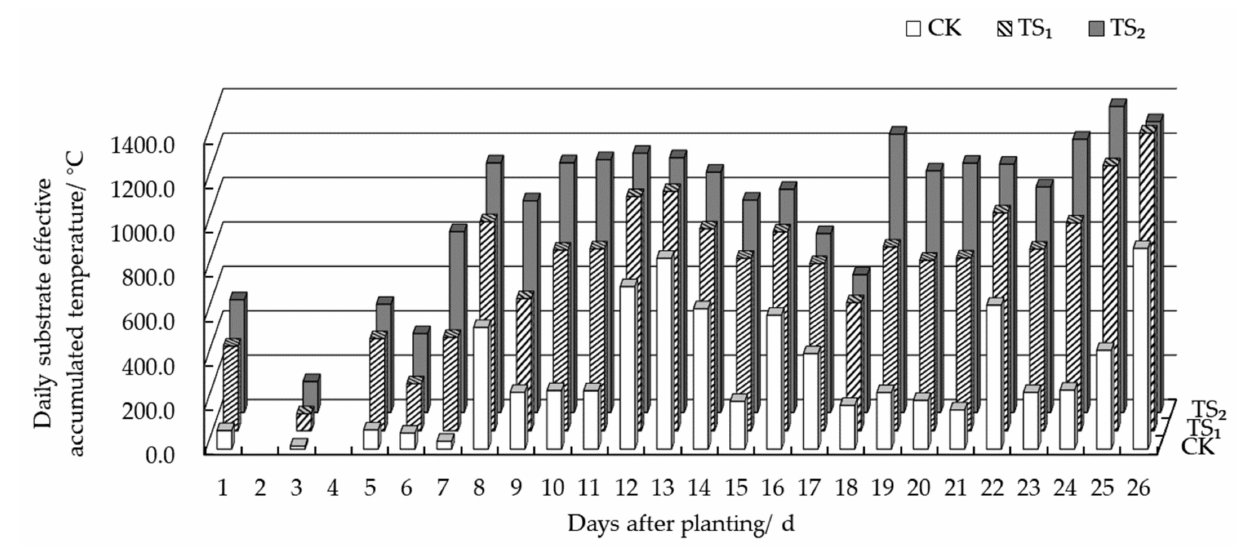
Figure 6. Daily substrate’s effective accumulated temperature of different treatments following tomato